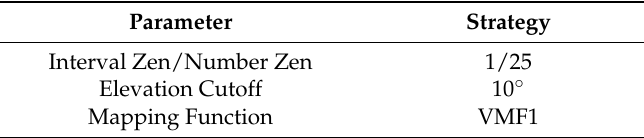
Table 2. Solution strategy for obtaining